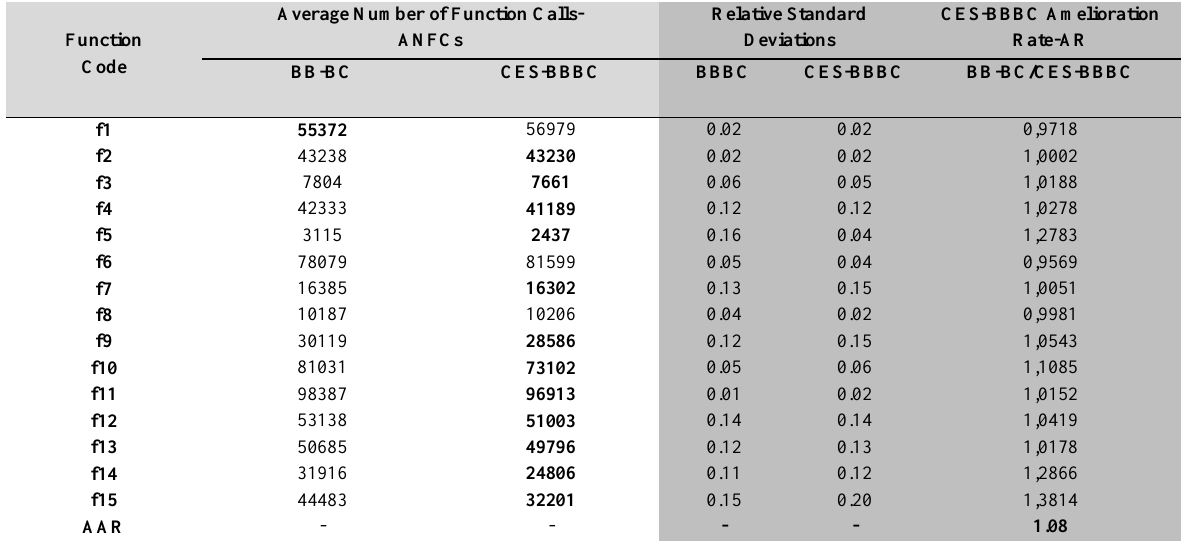
Table 3. Comparison of plain BB-BC algorithm and CES-BB-BC on CEC’17 test suite.